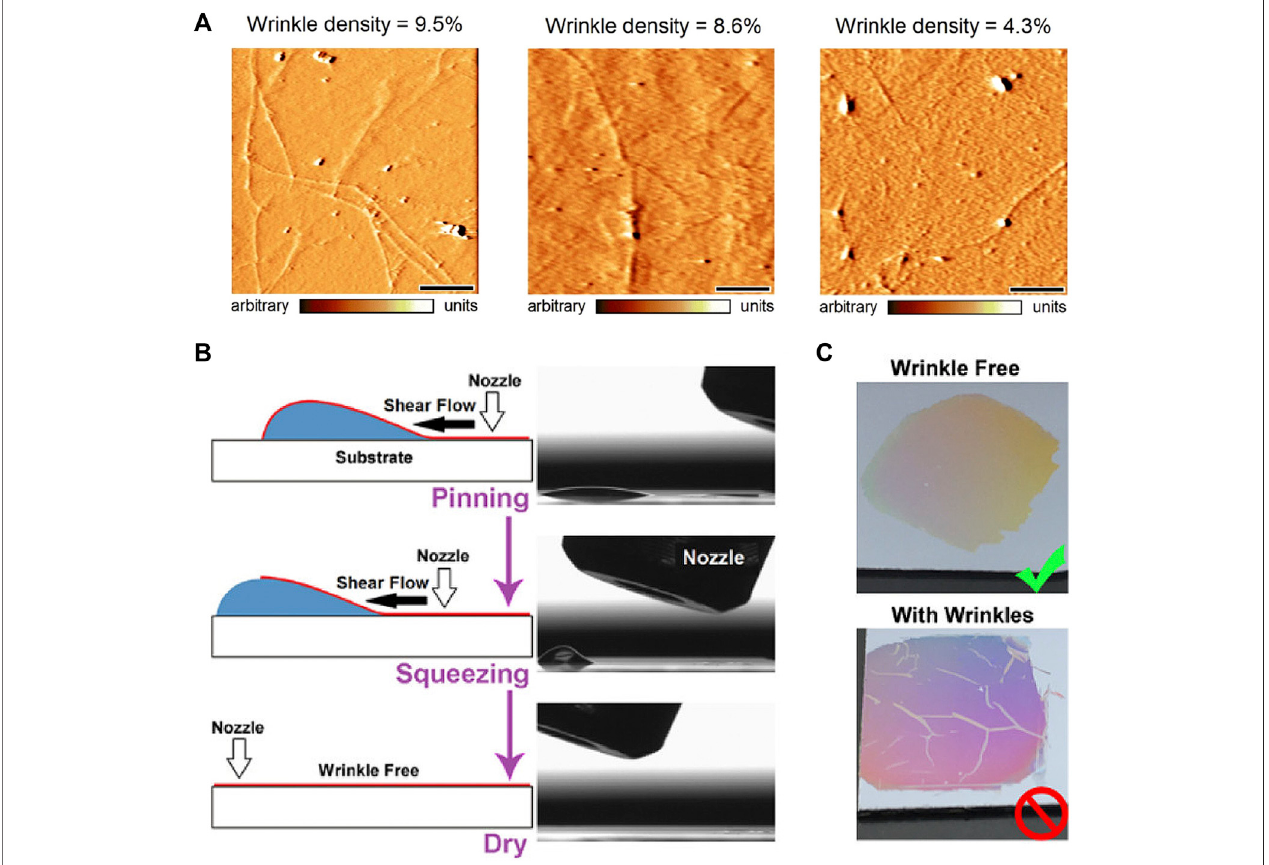
FIGURE 2 | Wrinkle suppression through modulation of the bilayer interface. (A) Wrinkle density of the graphene fi lm on substrates with different roughness. The substrates fromlefttorightare fl at SiO 2 , fl at HfO 2 , androughHfO 2 ,withincreasedinitial surfaceroughnessfrom lefttoright. Also,theresulted wrinkle density decreases fromlefttoright.Scalebar:1.5 μ m(reproducedwithpermissionfromLanzaetal.,2013,theAmericanInstituteofPhysics). (B) Schematic(left)andcorrespondingoptical image (right) of directional air fl ow – assisted wet transfer of anodic aluminum oxide (AAO) fi lm. (C) The wrinkle-free fi lm by fl ow-assisted wet transfer (top) and wrinkled fi lm by normal wet transfer (bottom) (reproduced with permission from Zhang et al., 2021, The American Chemical Society).